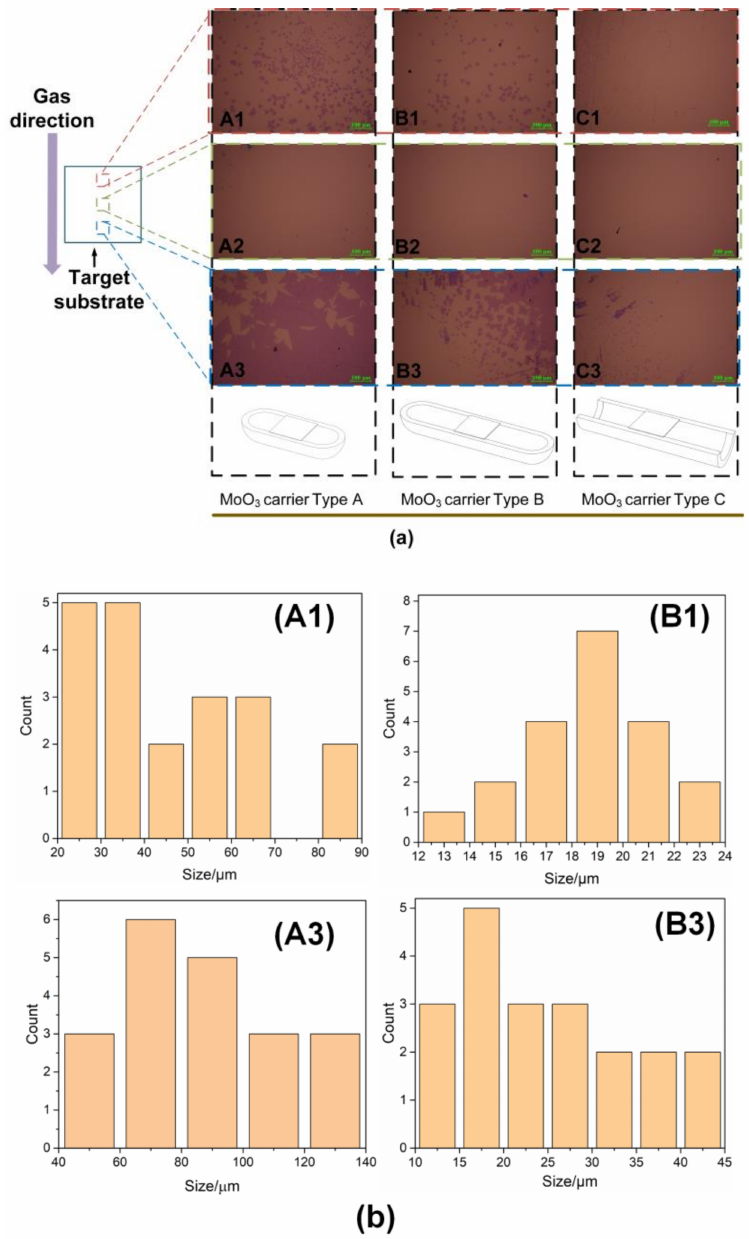
Figure 4. ( a ) MoS2 crystals formed on target substrate above three types of MoO3 carrier, ( b ) grain size statistics under different conditions: the size and distribution of grains under conditions A1, A3, B1 and B3 were significant and collected; A1 and A3 related to the upstream and downstream zones of the target surface above MoO 3 carrier A, respectively and B1 and B3 related to the upstream and downstream zones of the target surface above MoO 3 carrier